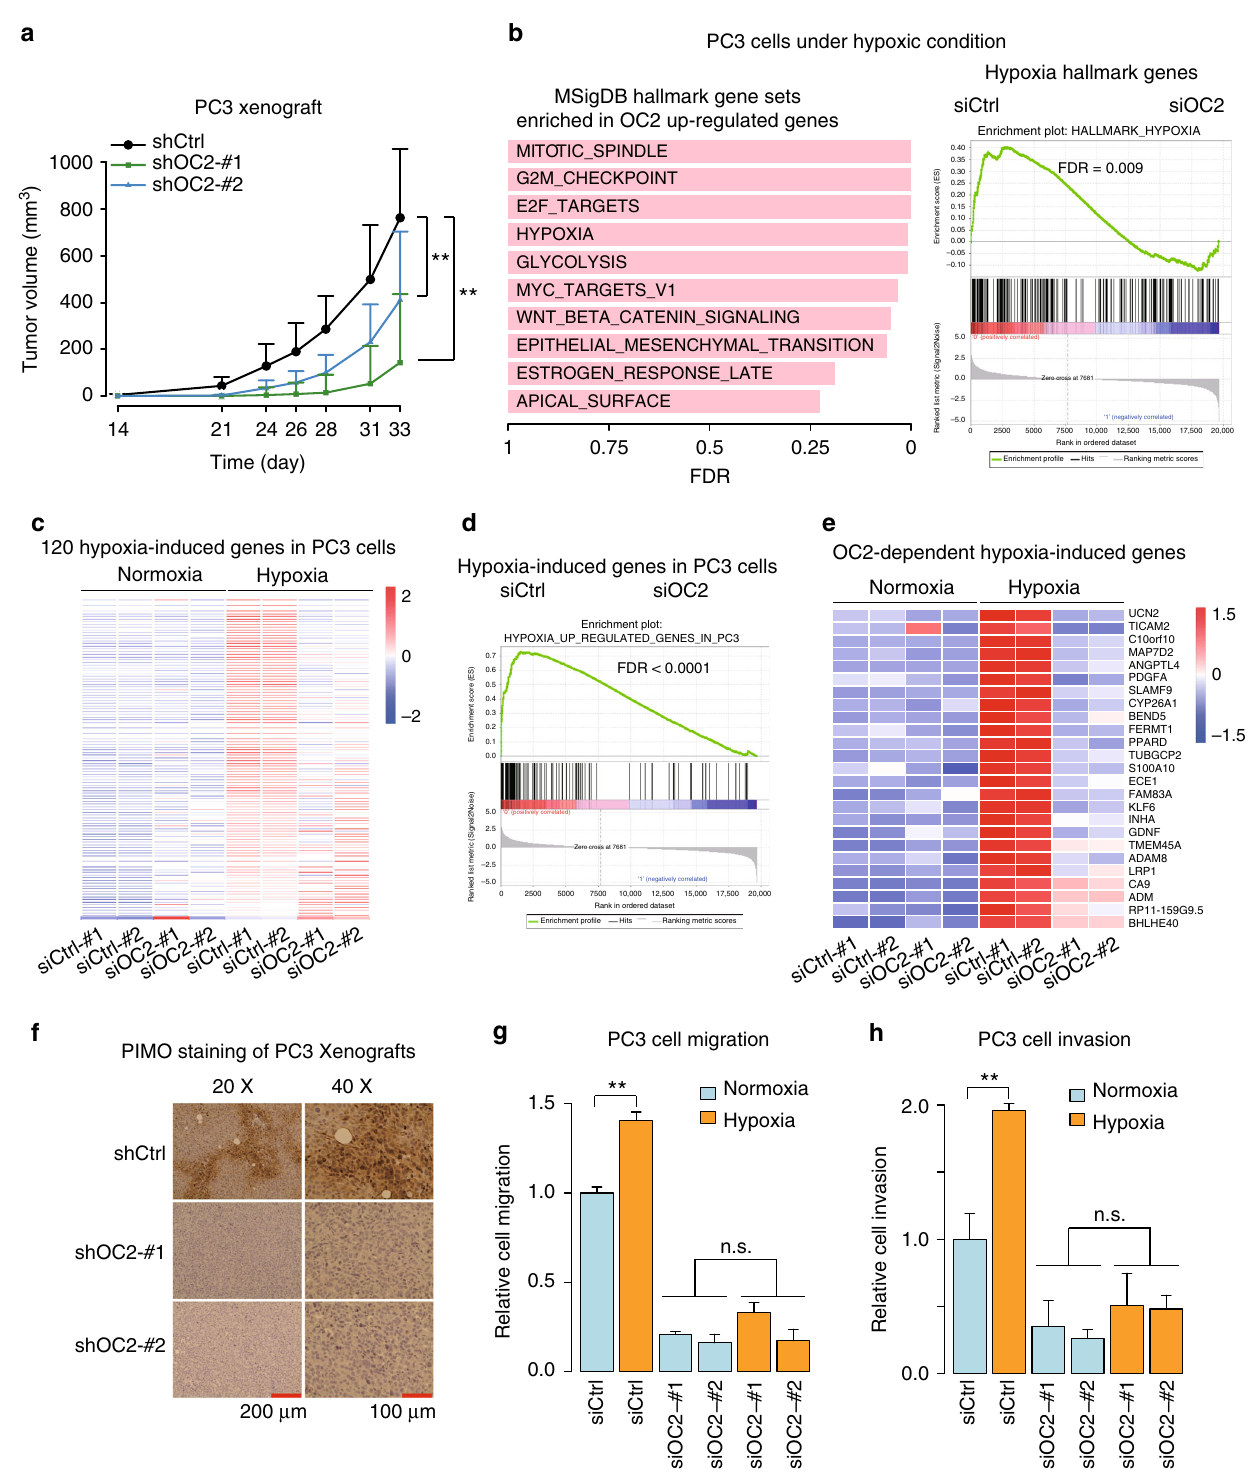
Fig. 2 ONECUT2 regulates hypoxia signaling in NE-like PC3 cells. a Lentiviral knockdown of ONECUT2 suppresses tumor growth in PC3 xenograft models. n = 9 for shCtrl; n = 10 for shOC2-#1; n = 10 for shOC2-#2. b Left panel: top 10 MSigDB Hallmark Gene Sets enriched in ONECUT2 upregulated genes under hypoxic conditions. Right panel: GSEA enrichment plot for “ Hypoxia ” gene set. Genes were ranked by fold changes between control and ONECUT2 knockdown samples in descending order. c Heatmap shows relative expression of 120 hypoxia-induced genes (fold change > 2 and P -value < 0.05) in PC3 cells with and without ONECUT2 knockdown under normoxic and hypoxic conditions. d GSEA enrichment plot of hypoxia-induced genes in PC3 cells. Genes were ranked by fold changes between control and ONECUT2 knockdown samples in descending order. e Heatmap shows abundance of ONECUT2- dependent hypoxia-induced genes. f Representative images of Pimonidazole (PIMO) IHC staining of PC3 xenograft tumors with and without silencing of ONECUT2. g , h The capacity of PC3 cell migration and invasion with and without silencing of ONECUT2, under normoxic and hypoxic conditions in PC3 cells. P -values were calculated by mixed-effects models of repeated-measures ANOVA for a , Wilcoxon rank sum test for c and one-way ANOVA for g and h . n.s. not signi fi cant; *: P < 0.05; **: P < 0.01. Source data are provided as a Source Data fi